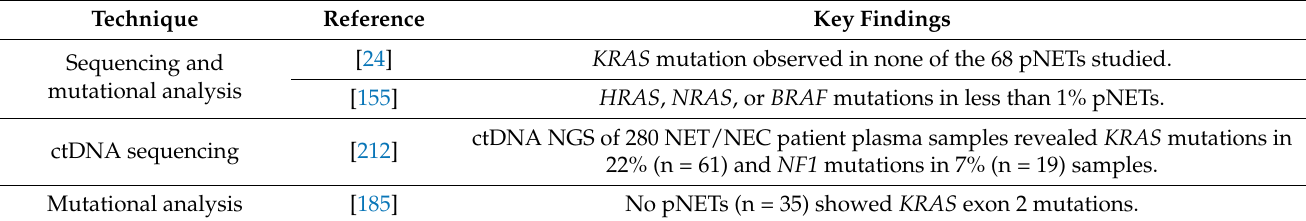
Table 8. Molecular profiling studies on Ras-MAPK signaling in